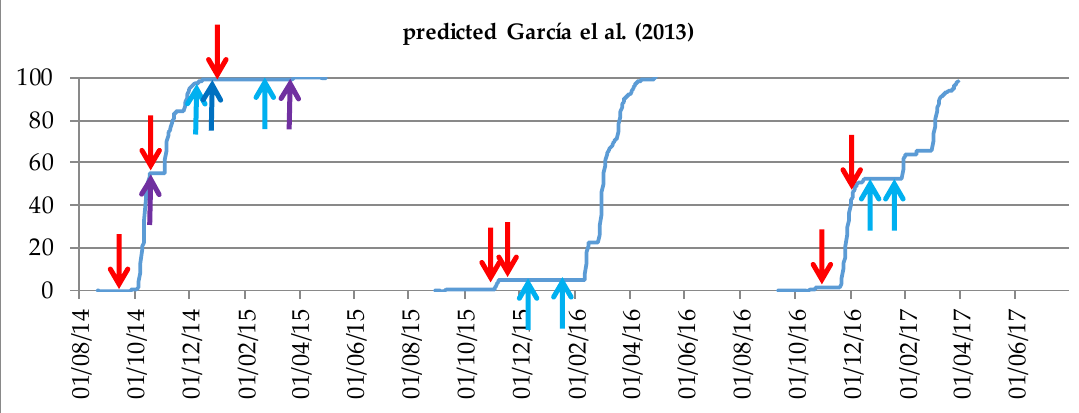
Figure 1. Simulation of the percentages of emergence for rigput brome ( Bromus diandrus Roth) throughout the three seasons, estimated with the emergence model developed by García et al. (2013). The initial hydrothermal time count started each season with the first important rains in September. Red arrows represent the sowing dates each season (24 September, 31 October, 23 January in 2014–2015; 6 and 27 November in 2015–2016; and 4 November and 2 December in 2016–2017). Purple arrows indicate the first centurion application (left) in RAPE on 29 October. The second application coincided with the herbicide application of the first sowing dates (light blue arrow, left), and centurion application in the pea crops (right) on 31 March. Light blue arrows indicate the applications of the corresponding herbicide in the first (left) and second (right) sowing dates (17 December and 4 March in 2014–2015; 23 December and 20 January in 2015–2016; 12 December and 25 January in 2016–2017). The dark blue arrow indicates the application of Buctril Universal in TRAD-1 on 15 January 2015; in 2015–2016 and 2016–2017 this application coincided with the second herbicide application dates (right light blue arrows).